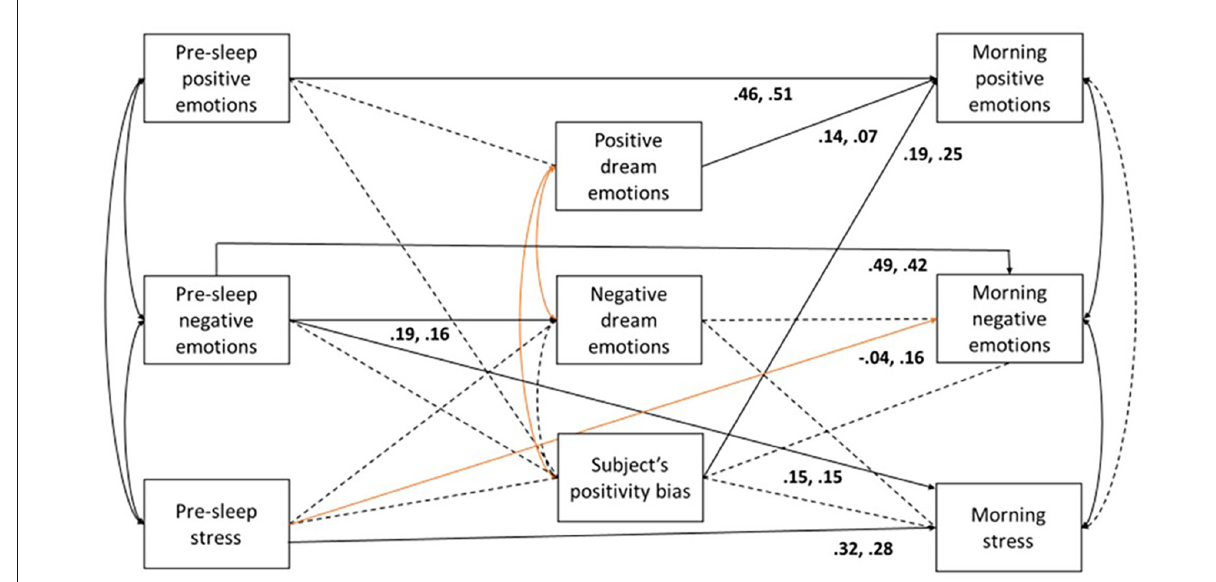
FIGURE2 Multi-group path analysis model. Solid lines represent p < 0.05; dotted lines represent p > 0.05. Curved lines represent correlations; arrows representregressedrelationships.Orangelinesrepresentpathsthatsignificantlydifferedbetweenpositiveandnegativedreamnights.Coefficients are standardized and are presented in the following order: positive dream nights ( n = 117 dreams) and negative dream nights ( n = 205